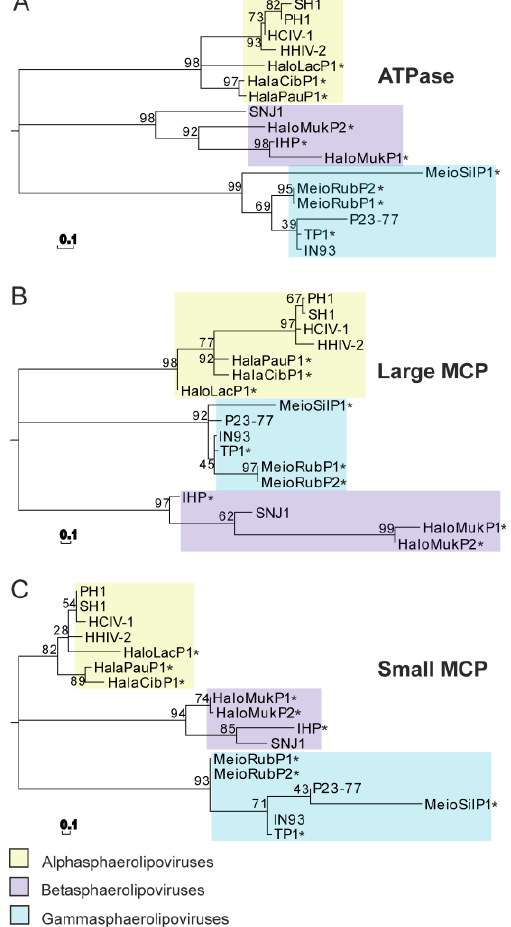
Figure 4. Maximum likelihood phylogenetic trees derived from protein sequences of the members of the family Sphaerolipoviridae and their related proviruses. ( A ) Packaging ATPases. ( B ) Large MCPs. ( C ) Small MCPs. Bars (0.1): the inferred number of substitutions per site. Reproduced with permission from [42] © American Society for Microbiology, mBio, 2016, vol. 7, no.4, e00699-16, doi: 10.1128/mBio.00699-16.